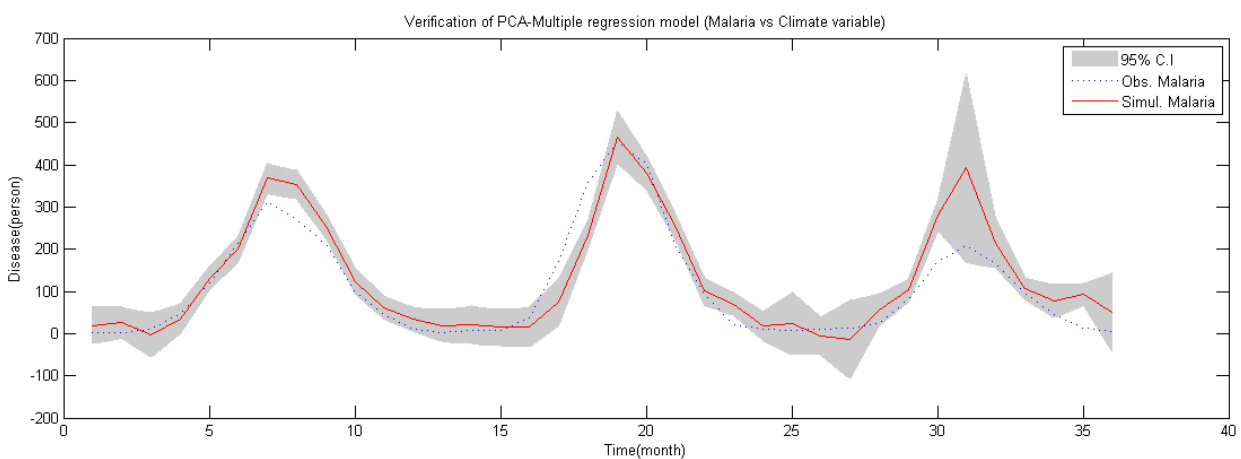
Figure 6. Validation of PCA-regression model (2009–2011).